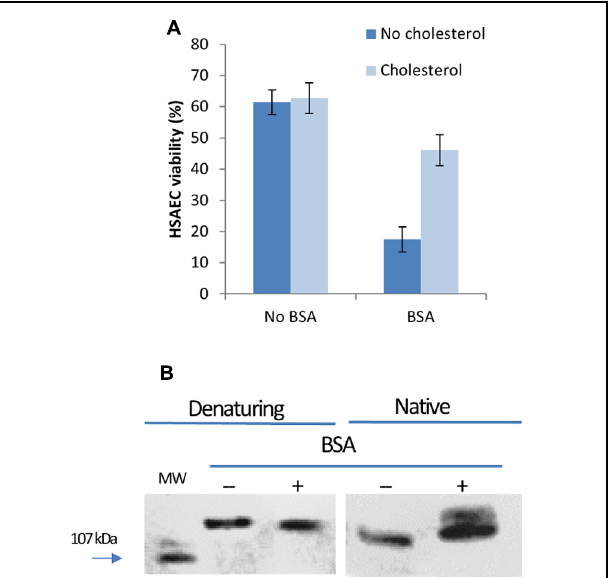
FIGURE 5 | CLO is inactivated in Sups concentrated in the absence of BSA. (A) Sups from BC1 microaerobic cultures grown in DMEM with or without 1 g L − 1 of BSA were filtered using Amicon centrifugal filters with a 3 kDa cut-off pore size. The retentates were diluted with corresponding medium to the original volume and assayed for CLO activity in triplicates after incubation with or without 10 μ g mL − 1 cholesterol for 1 h at room temperature. (B) Retentates from filtration were run on SDS-PAGE gels and transferred to nitrocellulose membranes. Membranes were blocked with 5% BSA in PBST and reacted with rabbit polyclonal anti-streptolysin O antibody followed by an anti-rabbit IgG, HRP-linked antibody. Blots were developed using SuperSignal West Dura Extended Duration Substrate (Thermo